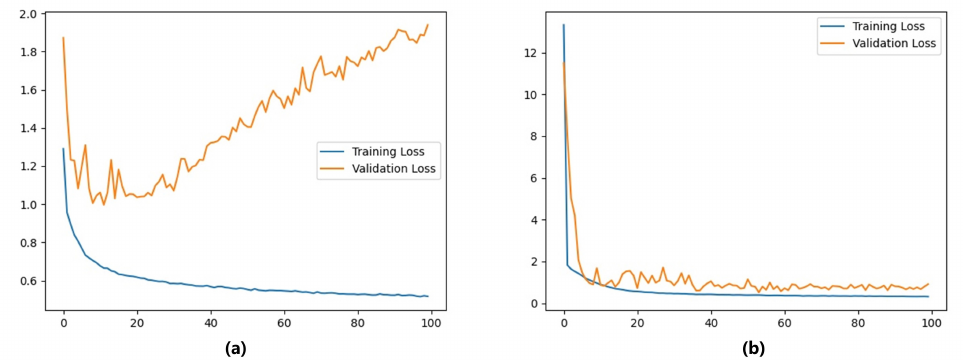
Figure 10. Loss when estimating the stapler contact force for two networks: ( a ) single video frame as input and ( b )